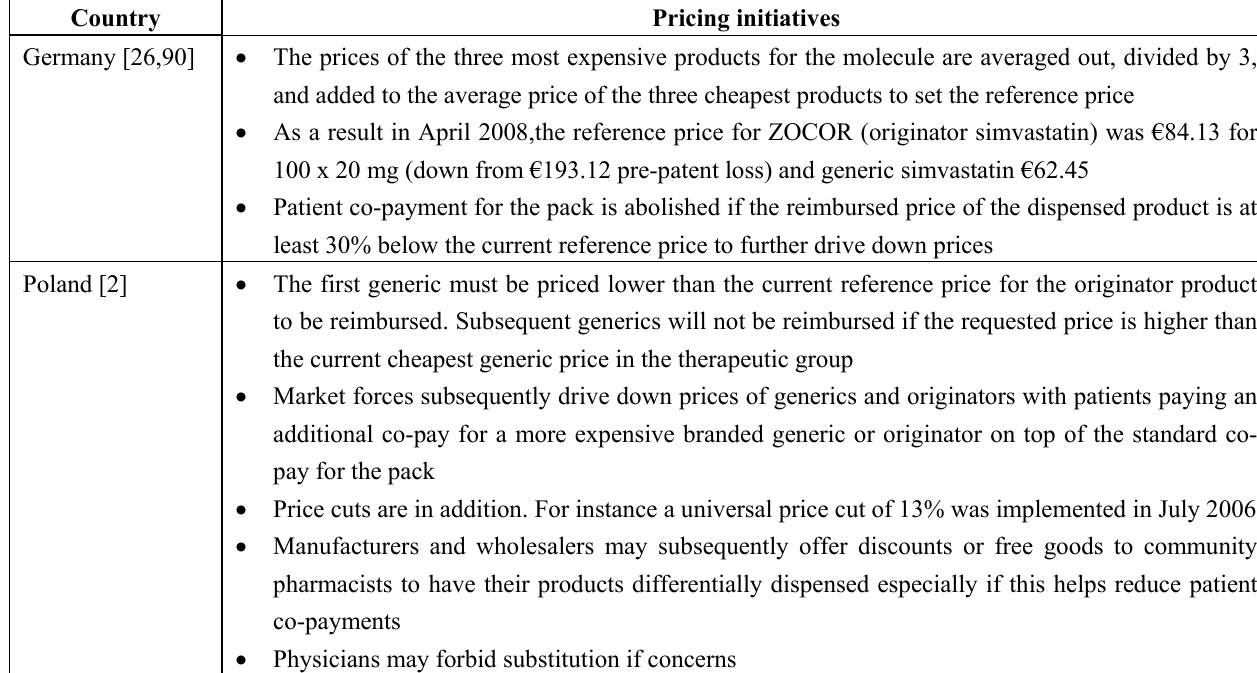
Table A3. Market Forces approaches to the pricing of generics in selected European countries. Country Pricing